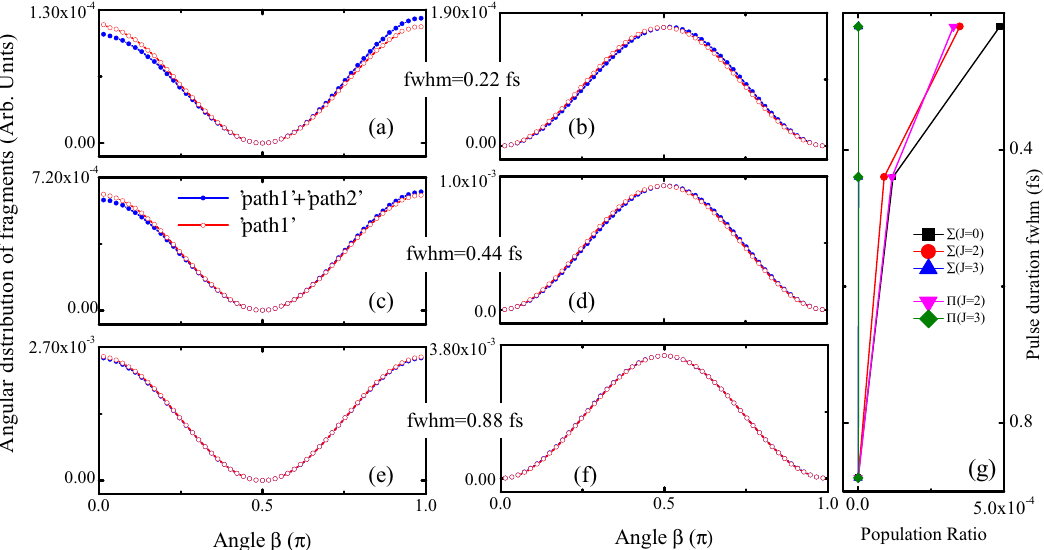
Fig. 3 Angular distribution of photofragments by pulses of different duration. Comparison pro fi les of angular distribution of photofragments triggered by a weak ( I = 10 13 W cm − 2 ) sub-cycle (fwhm = 0.22 fs ( a , b )) and few-cycle pulses (fwhm = 0.44 fs ( c , d ) and 0.88 fs ( e , f )) with CEP = 0. Labels `path1' + `path2' indicate the simulations taking into account all dipole interactions. The angular distribution of photofragments computed with model `path1' (ignoring all the permanent dipole moments) coincide well with cos 2 β or sin 2 β . The population ratio of various excited J state over J = 1 state in excited electronic state is shown in panel ( g